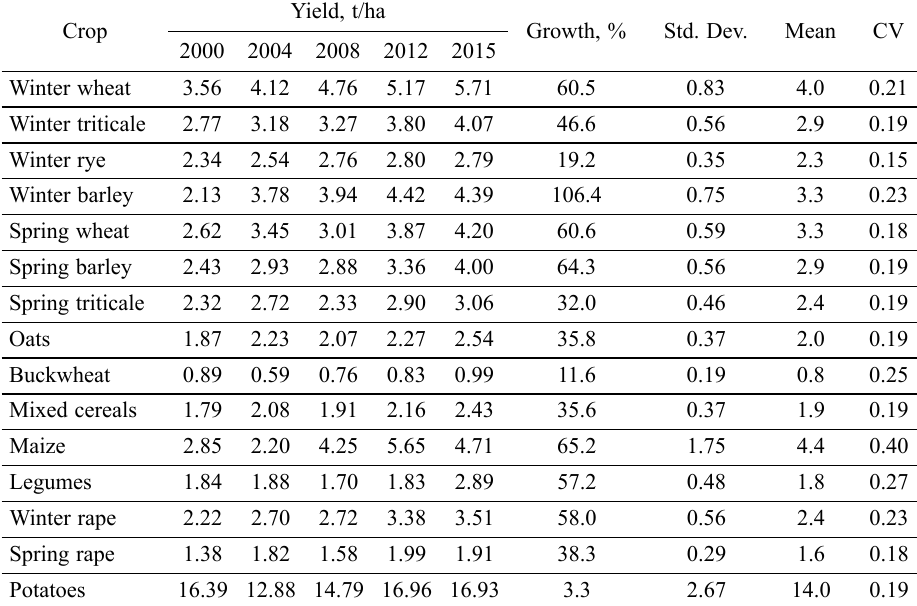
Table 1. Yield change for selected crops in Lithuania, 2000–2015 Yield, t/ha Crop Growth, % Std.